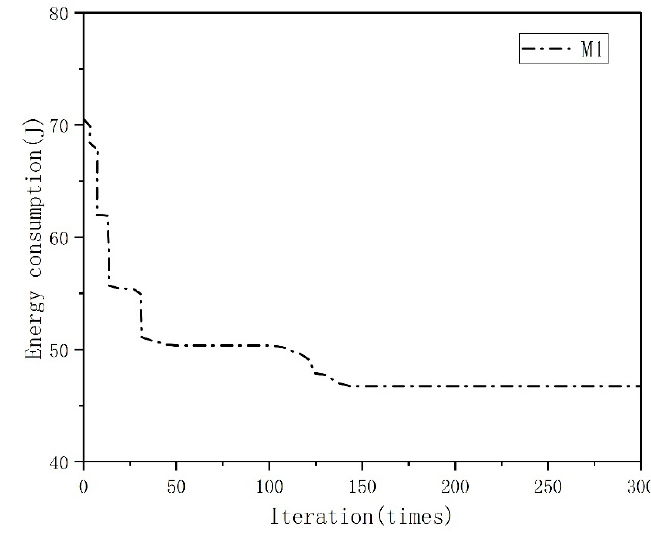
Figure 5. Energy consumption iterative curve of lathe.